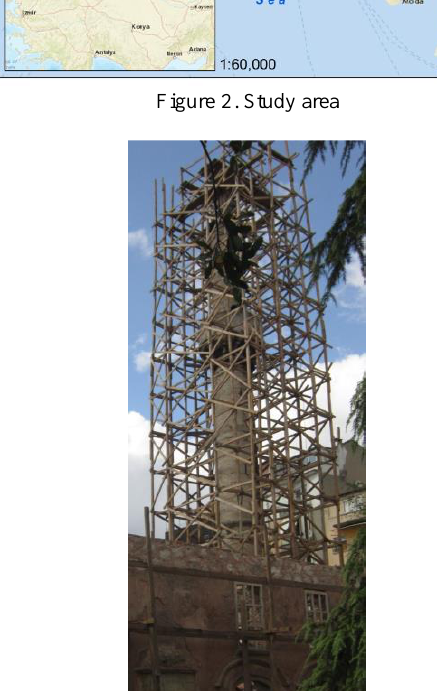
Figure 3. View of minaret